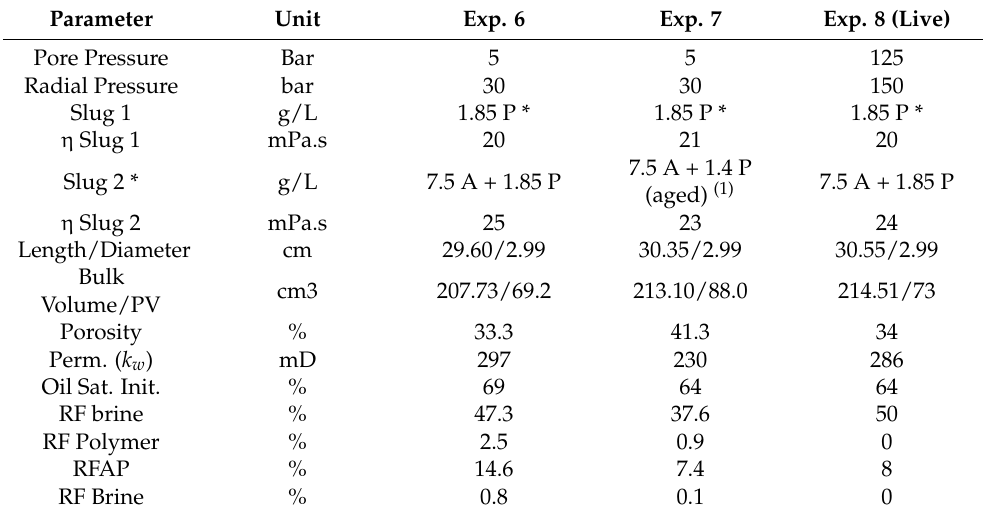
Table 10. Summary of results obtained for sand pack flood experiments performed in this work. Core orientation was vertical and injection rate was 1 ft/day Viscosities are taken at 7.94 s − 1 . Experiments performed at 49 ◦ C.